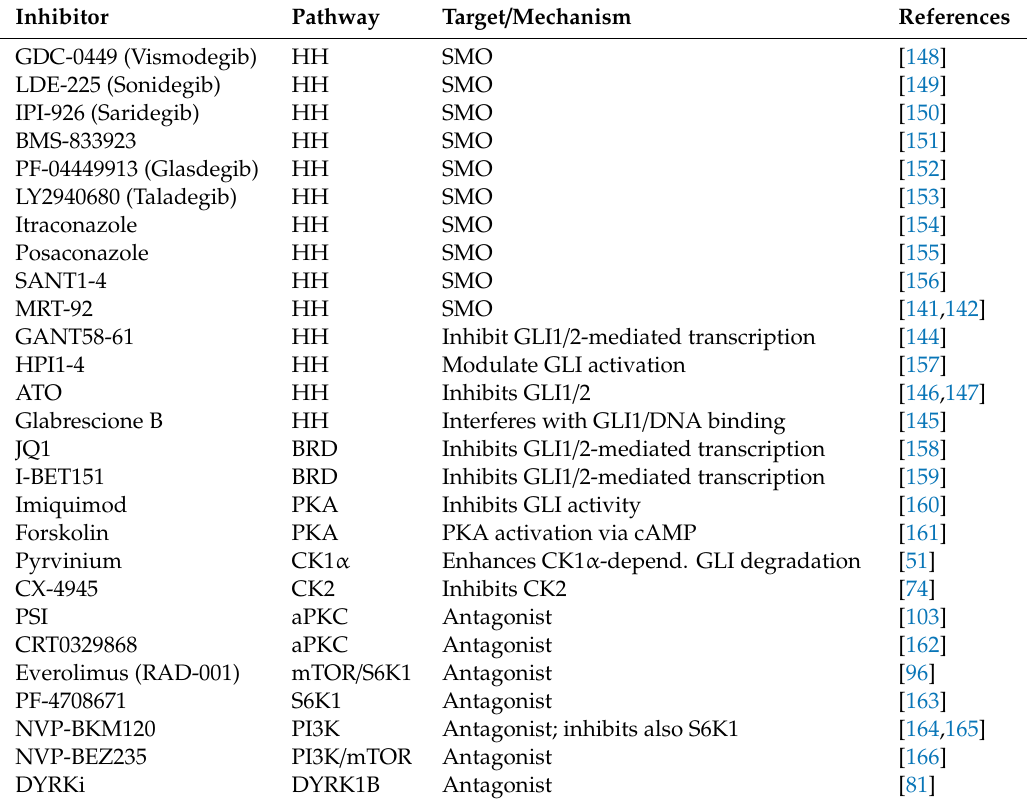
Table 2. Hedgehog pathway antagonists and other inhibitors mentioned in the text and in Figure 2. Inhibitor